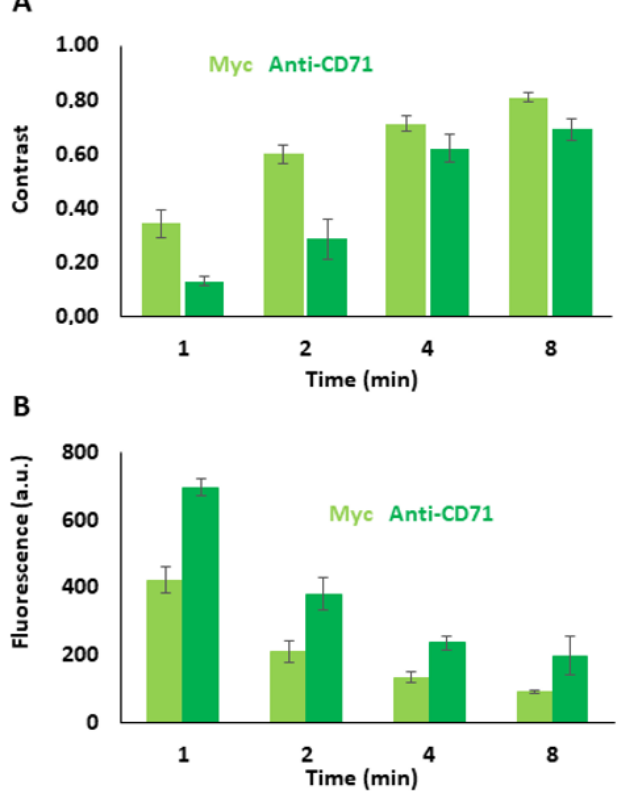
Figure 3. ( A ) Correlation between plasma treatment time and contrast using di ff erent labeled Figure 3 fluorescence biomolecules. ( B ) Correlation between plasma treatment time and fluorescence intensity of the dot